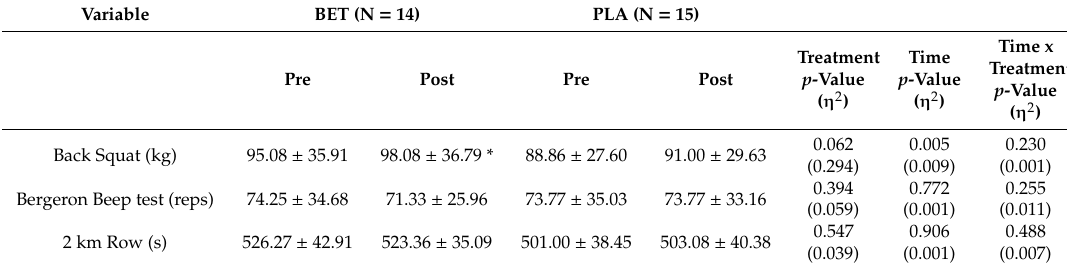
Table 3. Performance test